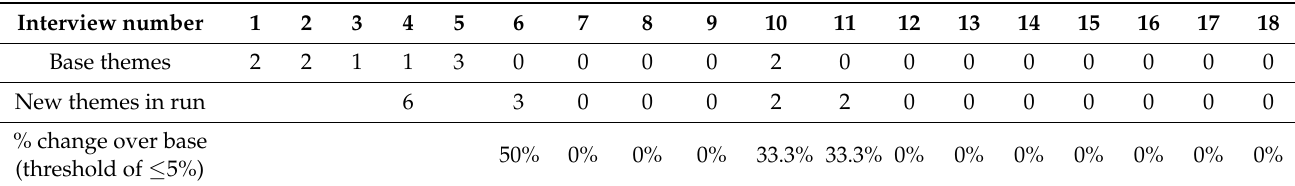
Table 1. Interview saturation